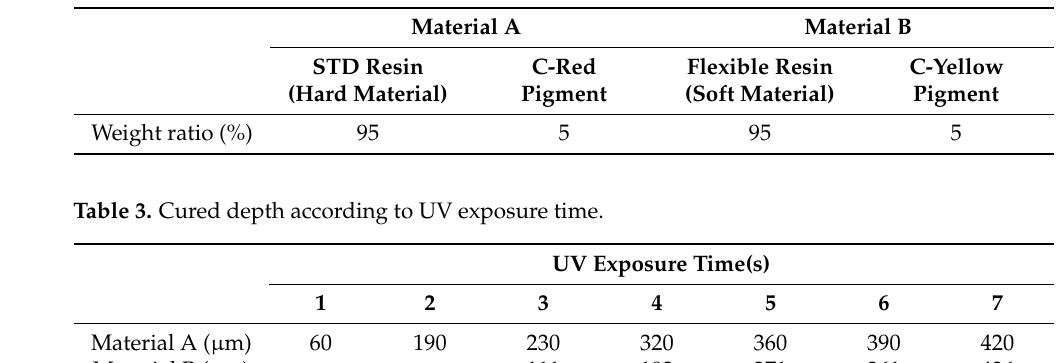
Table 2. Weight ratio of the composite materials.